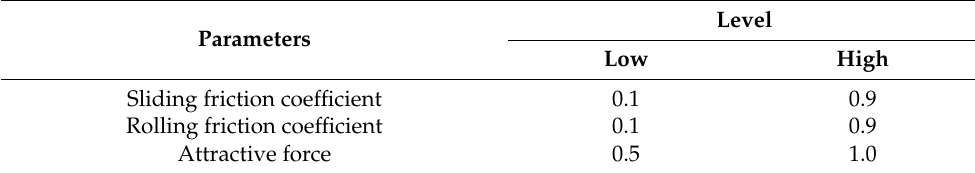
Table 1. Definition of high and low levels for the parameters considered in the calibration.